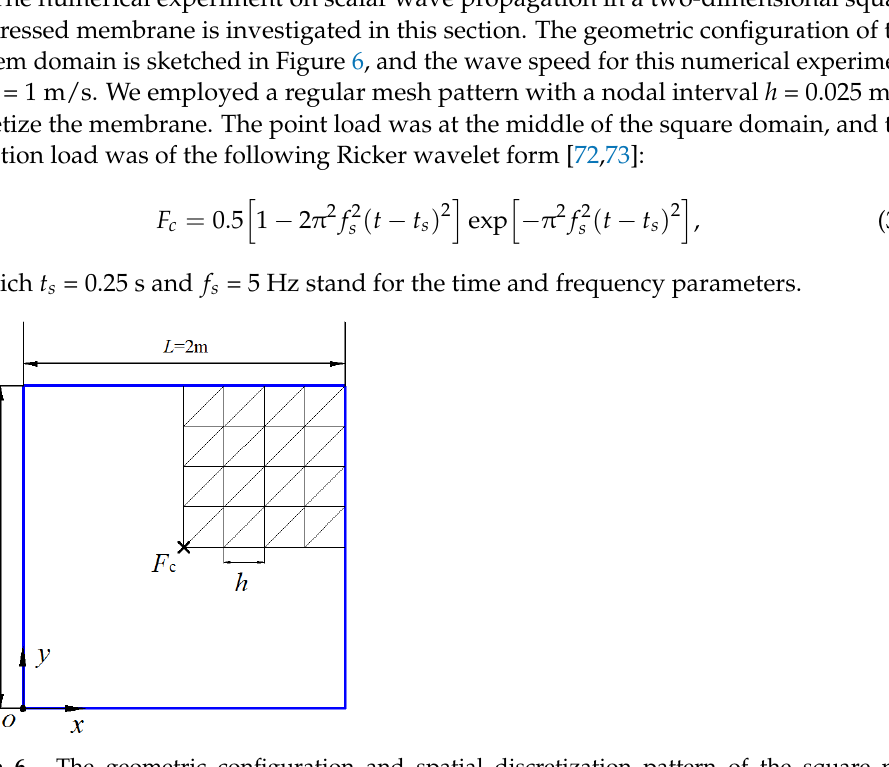
Figure 6. The geometric configuration and spatial discretization pattern of the square pre-stressed membrane.